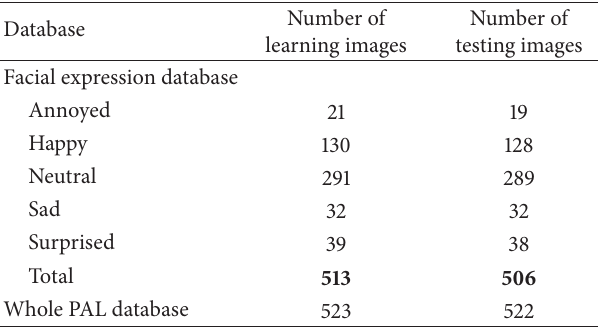
Number of Number of learning images testing images